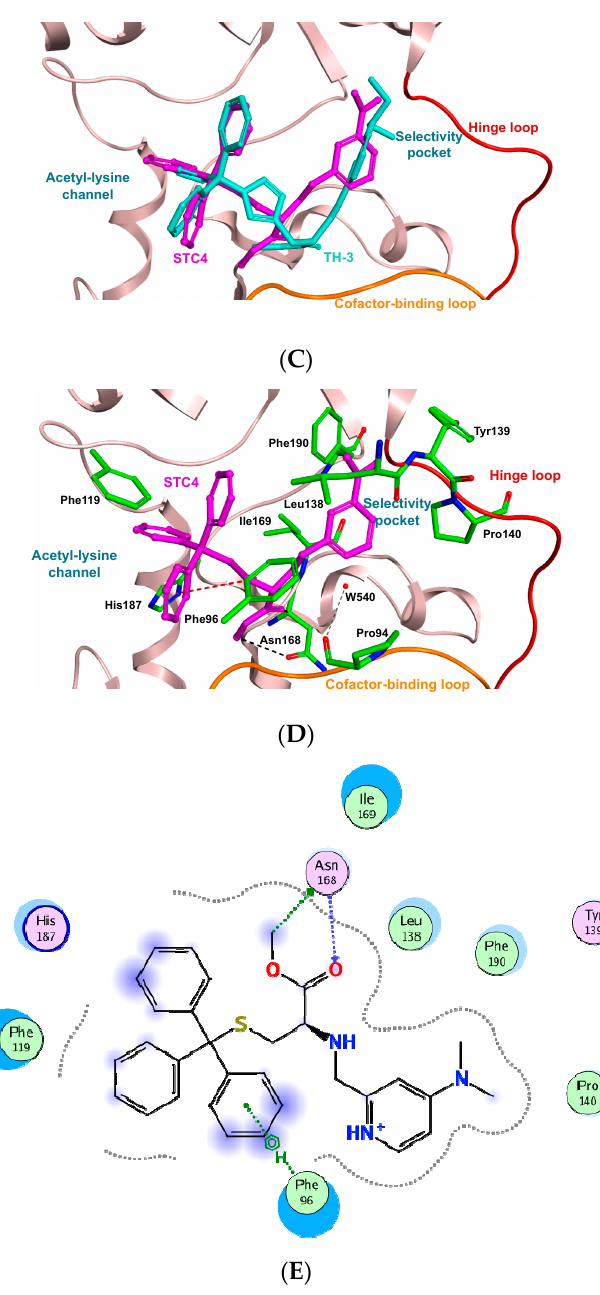
Figure 4. The top-ranking docked position of STC4 to the SIRT2 active site (PDB code 4RMG) as predicted by MOE 2019.01. ( A ) Comparison of modeled binding of the co-crystallized ligand SirReal2 (green sticks) and its superposed docking conformation (yellow sticks). ( B ) Comparison of modeled binding of STC4 (magenta ball-and-stick) and SirReal2 (green sticks). ( C ) Comparison of modeled binding of STC4 (magenta ball-and-stick) and TH-3 (cyan sticks). ( D ) Detailed binding of STC4 (magenta ball-and-stick) displaying hydrogen bonds (black dashed line) and CH- π interactions (red dashed line) with the key amino acid residues (green sticks). ( E ) 2D depiction of STC4 binding interactions with the key amino acid residues.